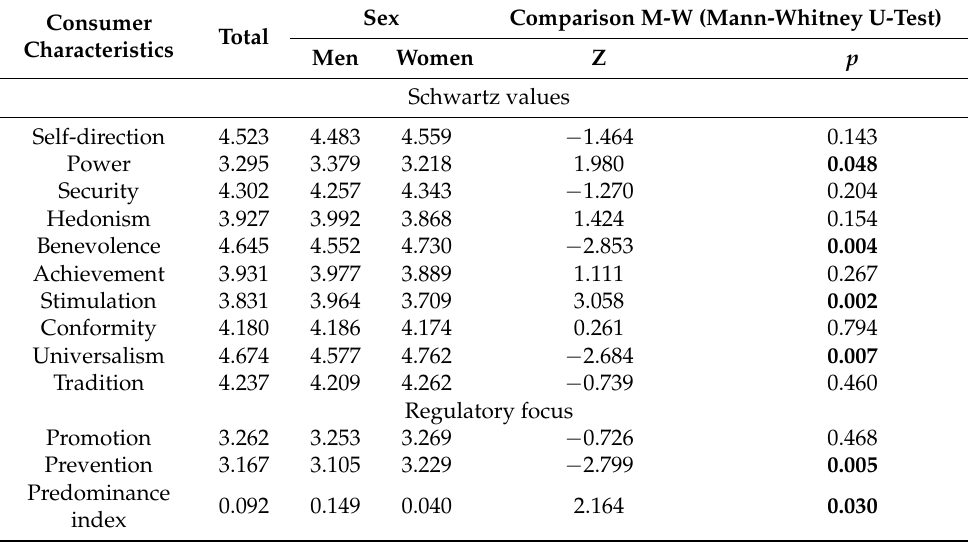
Table 4. The Schwartz values and regulatory focus by sex.